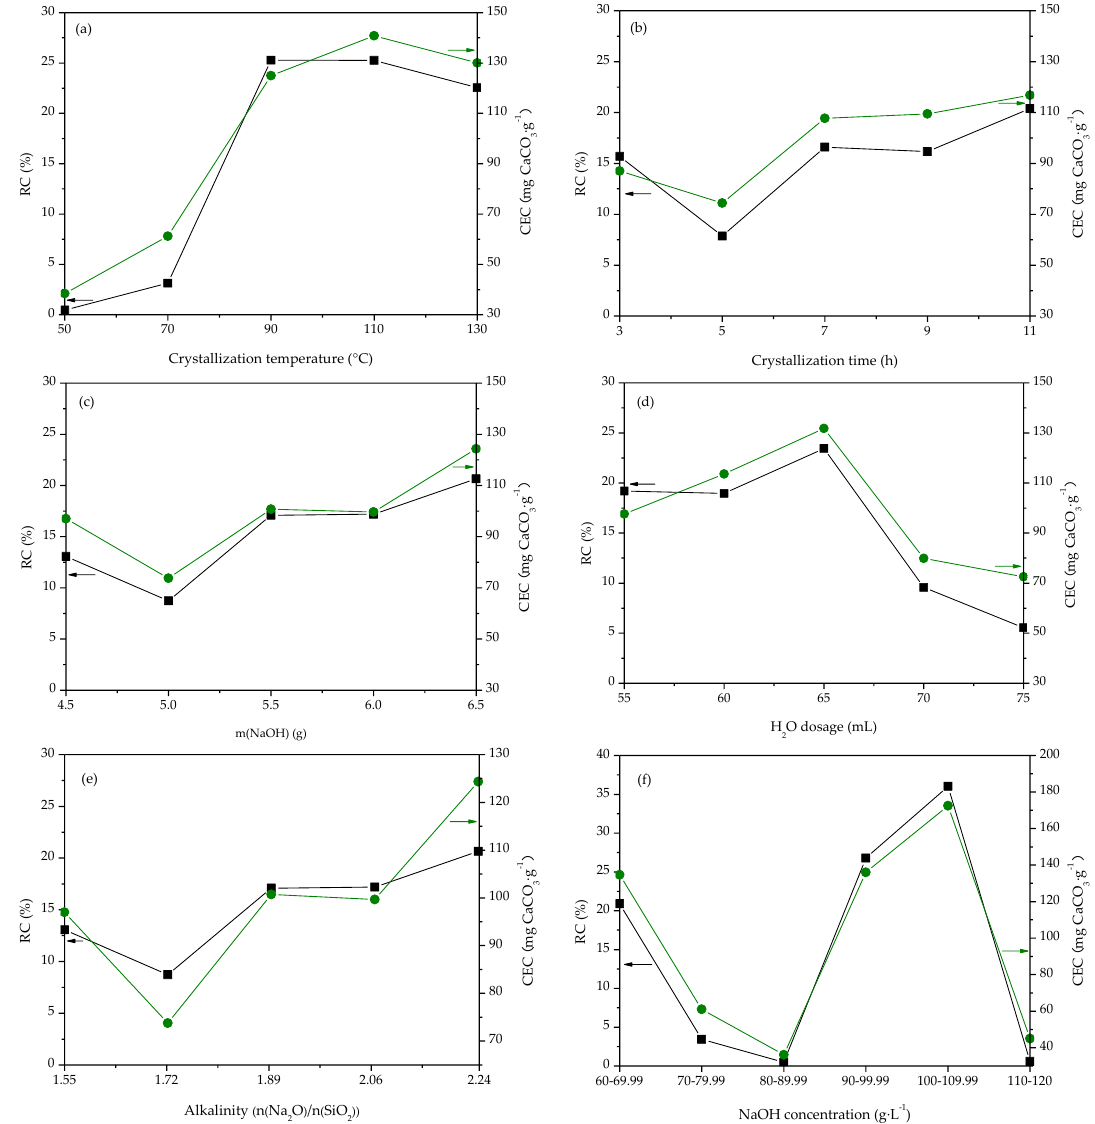
Figure 5. Effects of level variation for studied parameters process on the cation exchange capacity (CEC) and relative crystallinity (RC) of synthesized 4A zeolite.